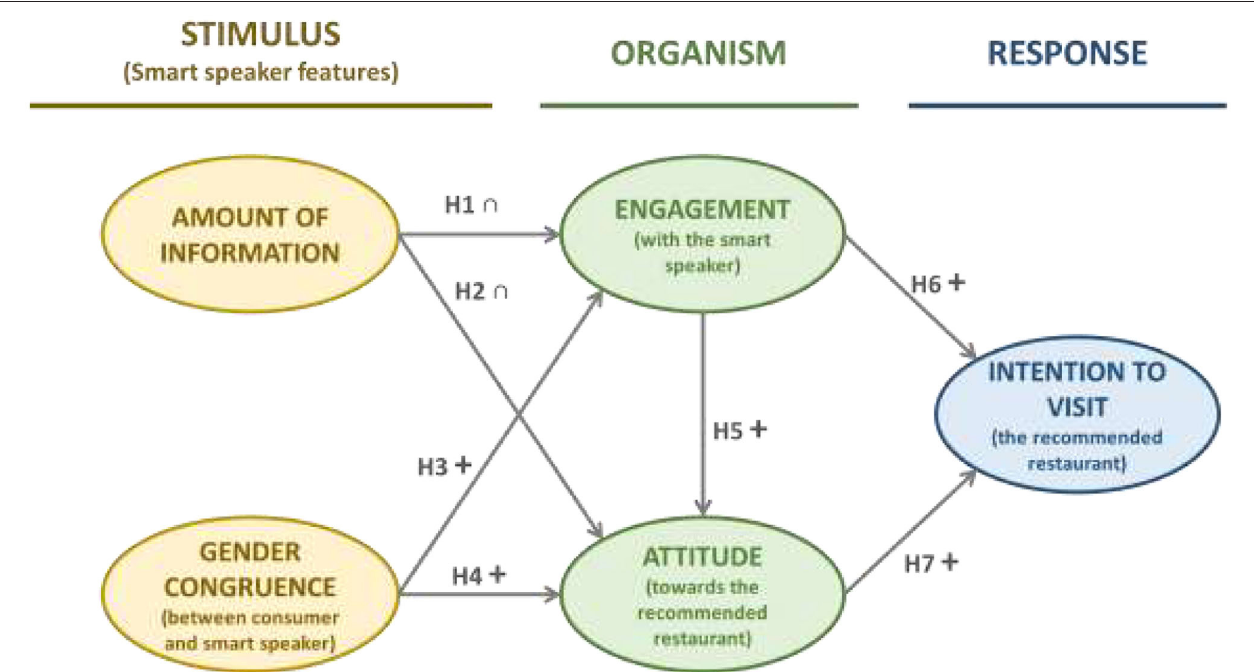
FIGURE 1 | Theoretical